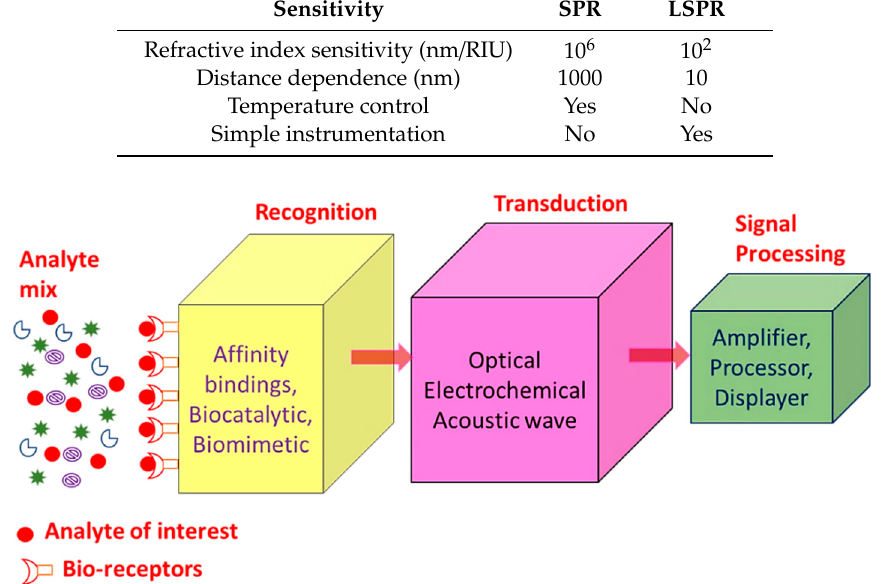
Figure 1. Summary of the different biosensor components.